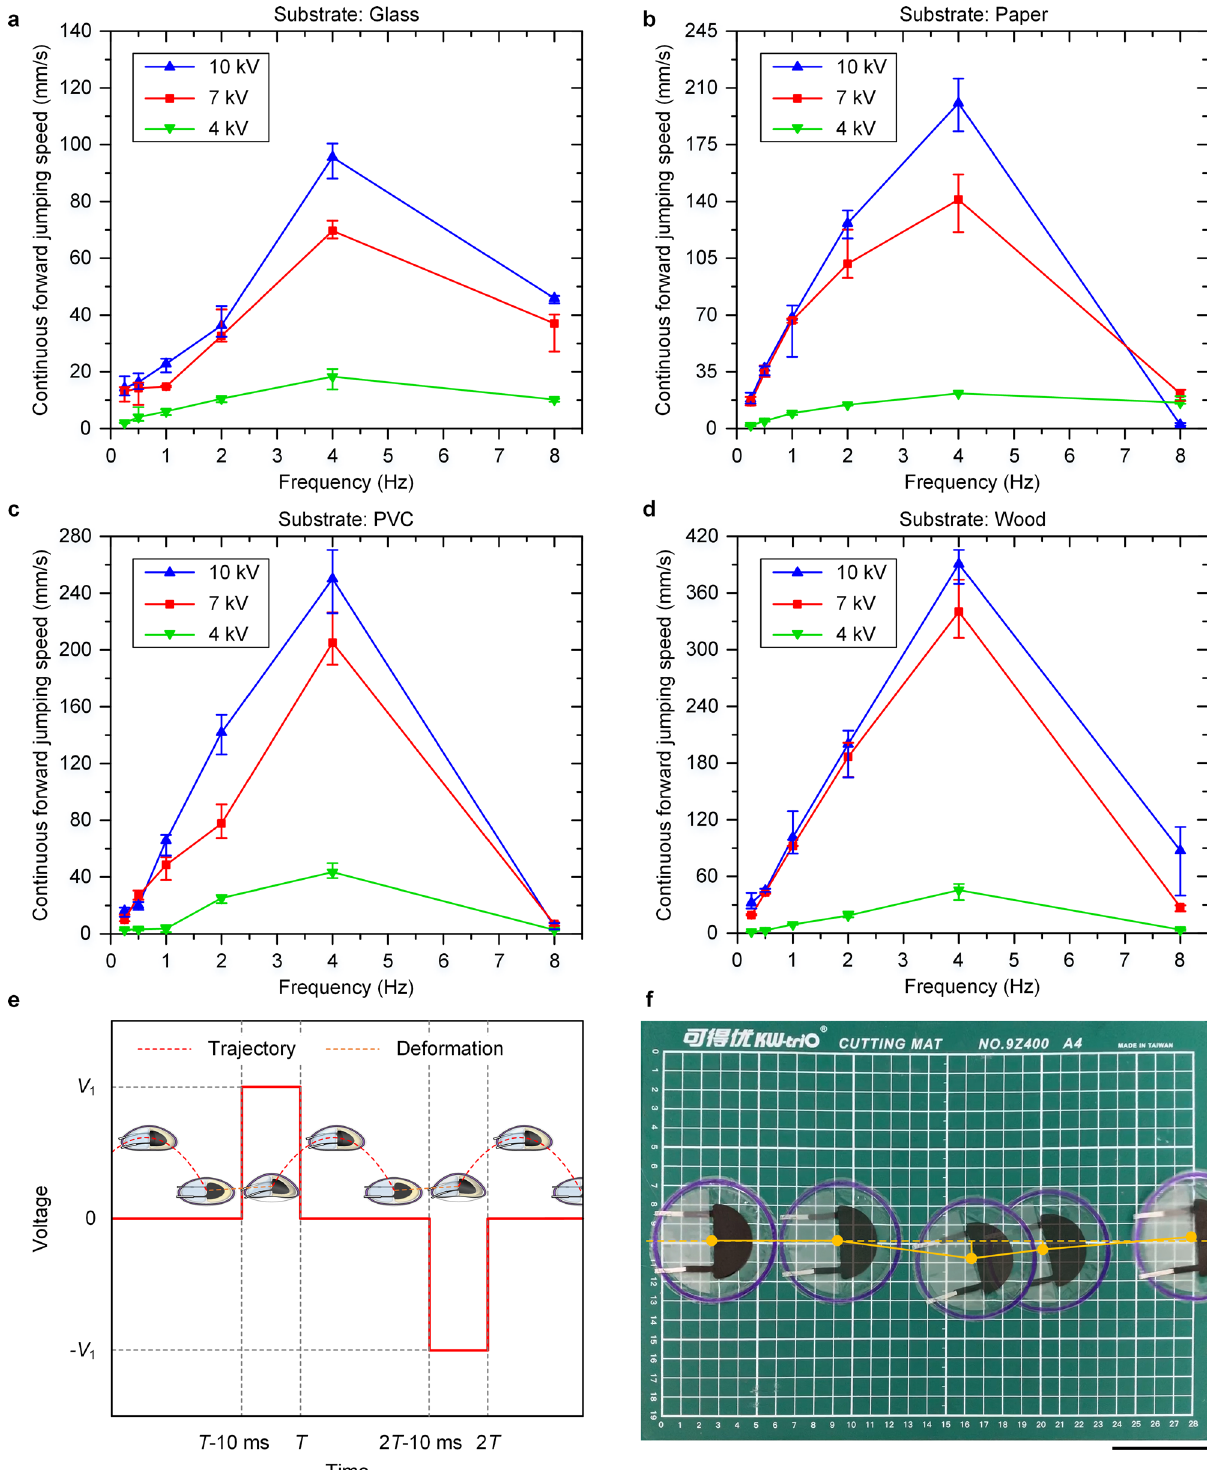
Fig. 3 Continuous jumping on different substrates. See also Supplementary Movie 3. a The relationship between CFJS and actuation frequency on the glass plate, where the slowest average CFJS = 95.6 mm/s (1.47 body lengths per second) was obtained at 4 Hz and 10 kV. b The relationship between CFJS and actuation frequency on the paper plate. c The relationship between CFJS and actuation frequency on the PVC plate. d The relationship between CFJS and actuation frequency on the wood plate, where the fastest average CFJS = 390.5 mm/s (6.01 body lengths per second) was obtained at 4 Hz and 10 kV. e The voltage application strategy and the corresponding robot motion states. f Composite image of the initial position and four landing points in continuous jumping on the PVC plate when CFJS = 250.1 mm/s at 4 Hz and 10 kV. The angle deviation of each jump was less than 8°. Scale bar, 5